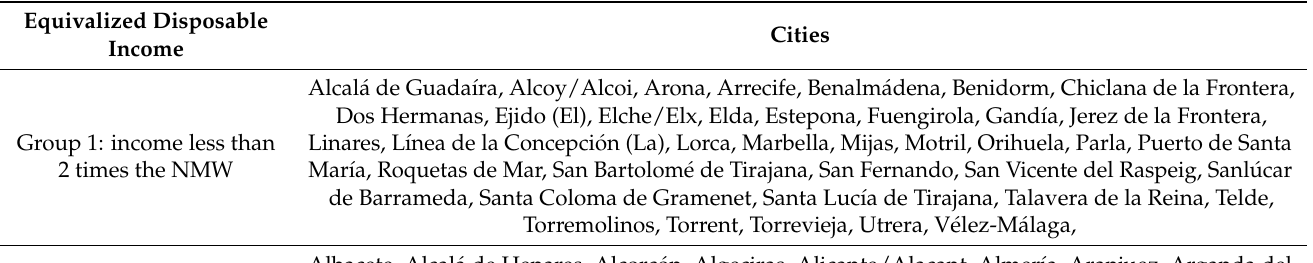
Table 1. Classification of cities according to their equivalized disposable